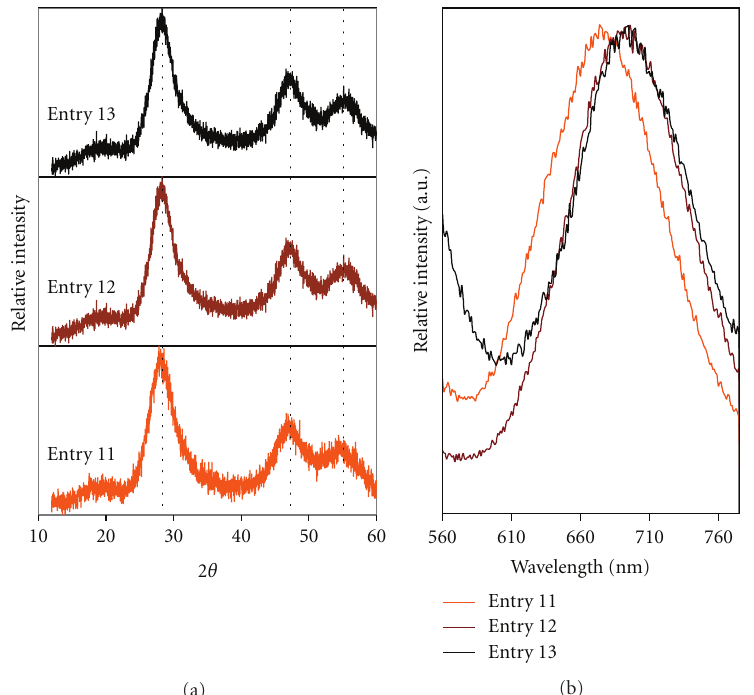
Figure 5: (a) Normalized XRD data of typical CuIn x Ga 1 − x S 2 soluble nanoparticles prepared from 160 to 200 ◦ C. (b) Normalized pho-